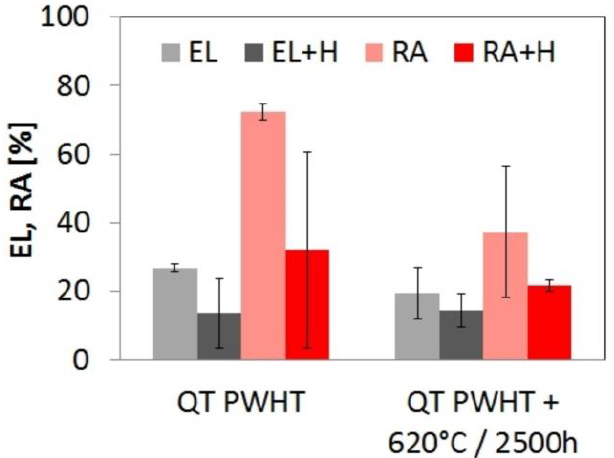
Figure 8. E ff ects of isothermal aging at 620 ◦ C and electrochemical hydrogen charging on the room-temperature plastic properties of T92 / TP316H dissimilar weldments (EL—total elongation, RA—reduction of area at fracture).